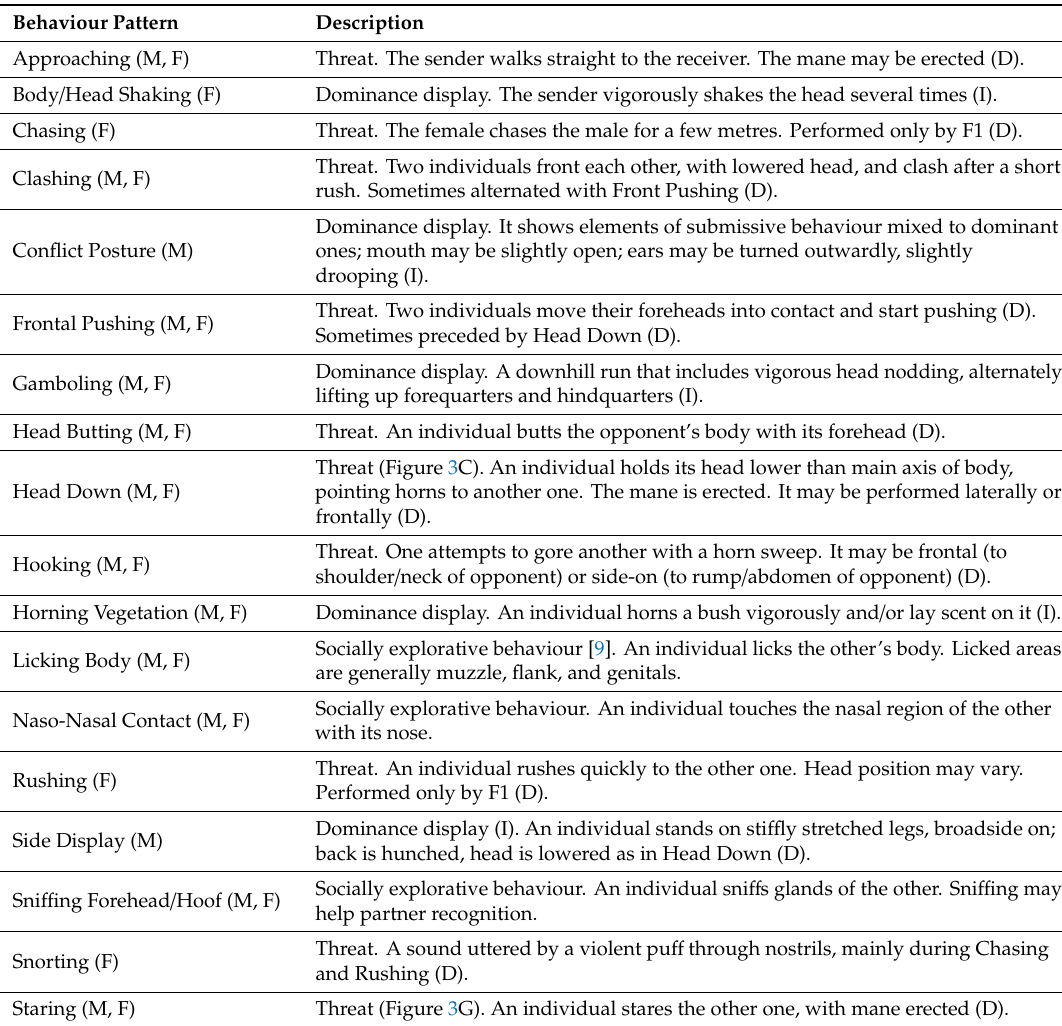
Table 2. Behavioural repertoire of the mainland serow: I, indirect form of aggression; D, direct form of aggression. M, male; F, female. See also Table 3.